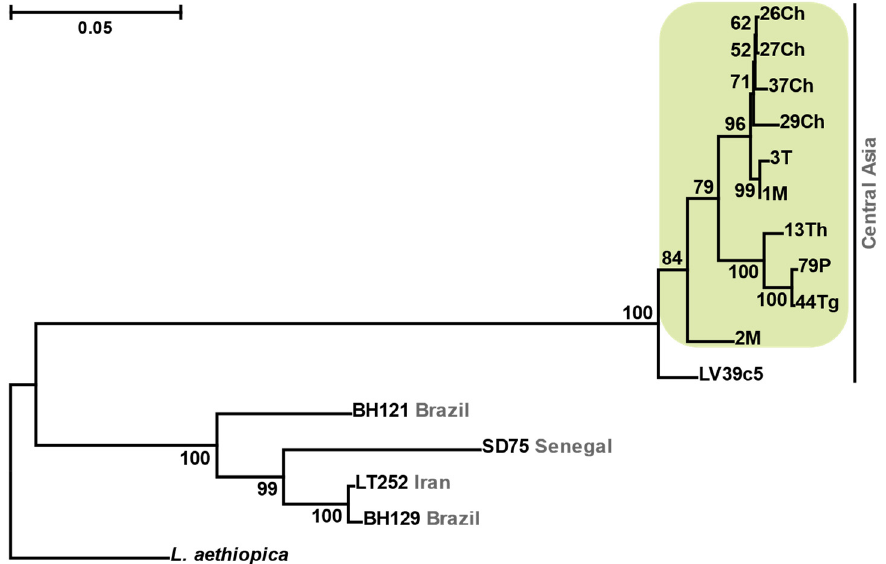
Figure 1. Maximum likelihood phylogenetic tree of L. major isolates inferred using SNP data. Scale bar indicates the number of substitutions per site. Values at branches are bootstrap supports. Leishmania aethiopica was used as an outgroup. Country/region of origin is specified in grey. Isolates studied here are highlighted in green.